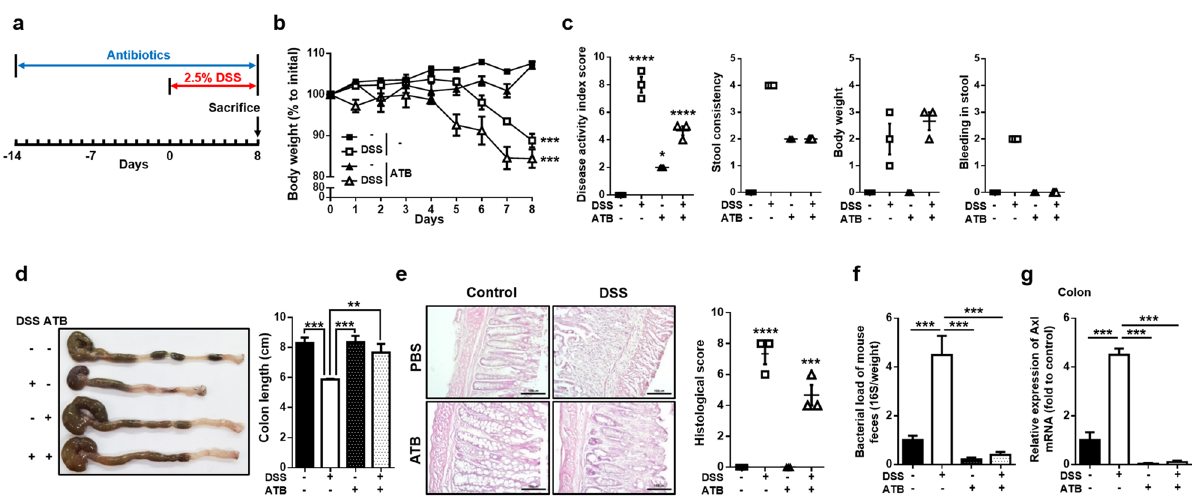
Figure 2. Axl expression was downregulated by the depletion of gut microbiota with antibiotics in DSS- induced colitis. ( a ) Mice were exposed to antibiotics during the entire experiment and administered with 2.5% DSS for 8 days before the sacrifice. ( b – e ) Body weights, DAI scores, macroscopic appearance, colon length, microscopic images, and histological scores were evaluated as described in Fig. 1. ( f ) The bacterial load was determined by copy numbers of the 16S rDNA gene per milligram of feces. ( g ) mRNA expression of Axl was analyzed by qRT-PCR in the colon tissues. Data are shown as the mean ± SEM values. Significance (*p < 0.05, **p < 0.01, ***p < 0.001, ****p < 0.0001) was compared with each group and calculated by the one-way ANOVA. Data are representatives of three independent experiments (n = 3 mice per